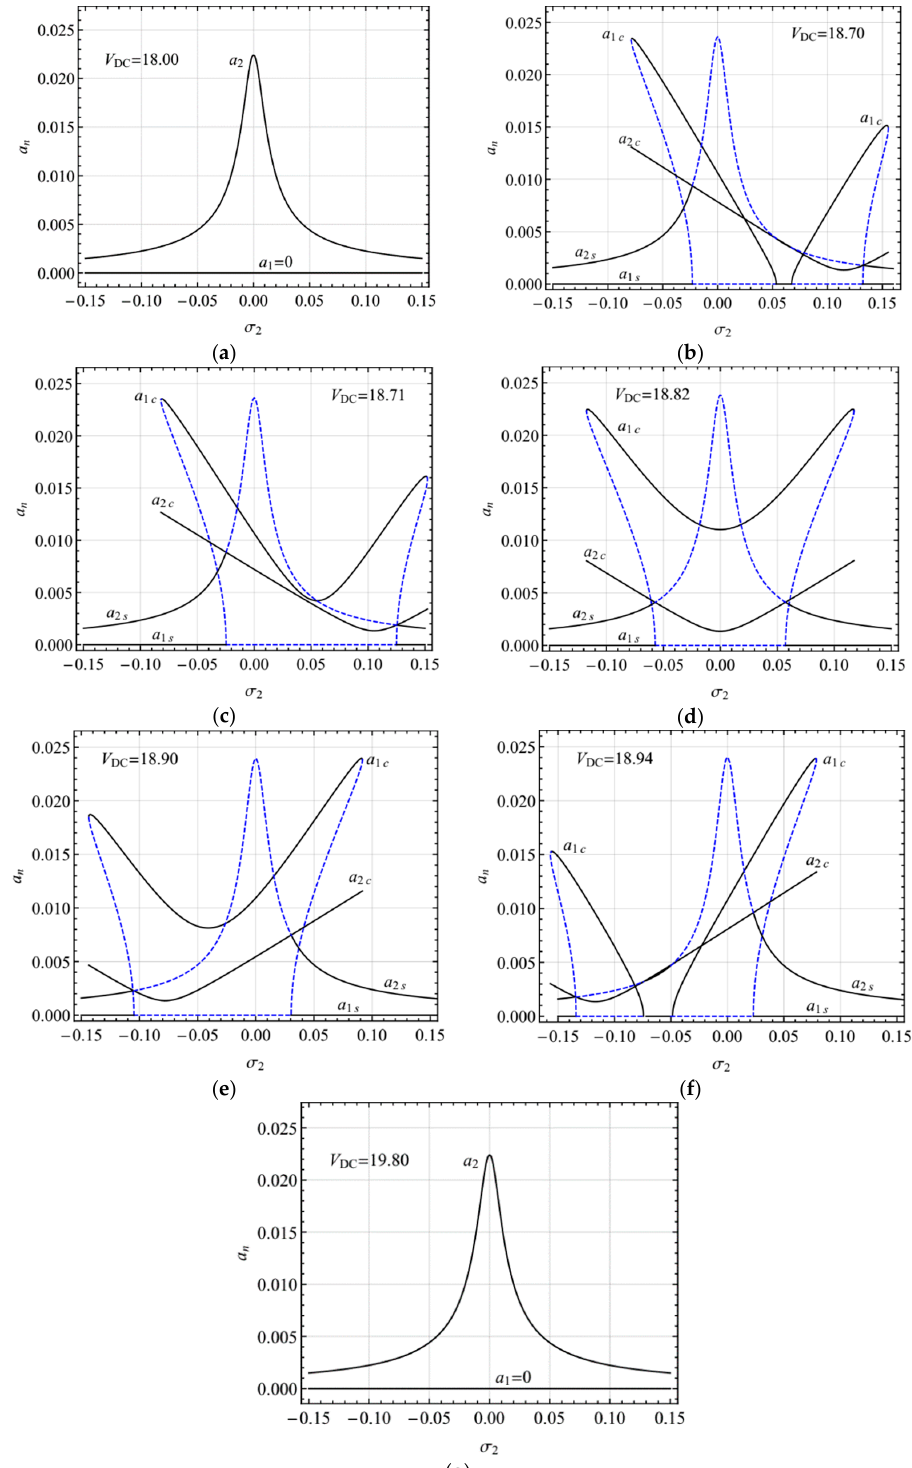
Figure 9. Frequency-response curves of the primary resonance of the second mode for different DC voltages: ( a ) V DC = 18.00 ( σ 1 = -0.75), ( b ) V DC = 18.70 ( σ 1 = -0.11), ( c ) V DC = 18.71 ( σ 1 = -0.10), ( d ) V DC = 18.82 ( σ 1 ≈ 0), ( e ) V DC = 18.90 ( σ 1 = 0.08), ( f ) V DC = 18.94 ( σ 1 = 0.11), ( g ) V DC = 19.80 ( σ 1 = 1.00).